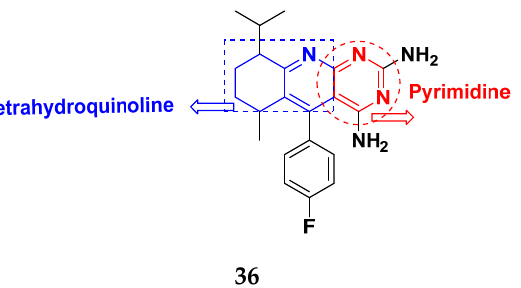
Figure 40. Structure of tetrahydro-pyrimido-quinoline based hybrid 36 . Table 30. In vitro cytotoxic activities of tetrahydro-pyrimido-quinoline based hybrid compound 36 . Compound No.